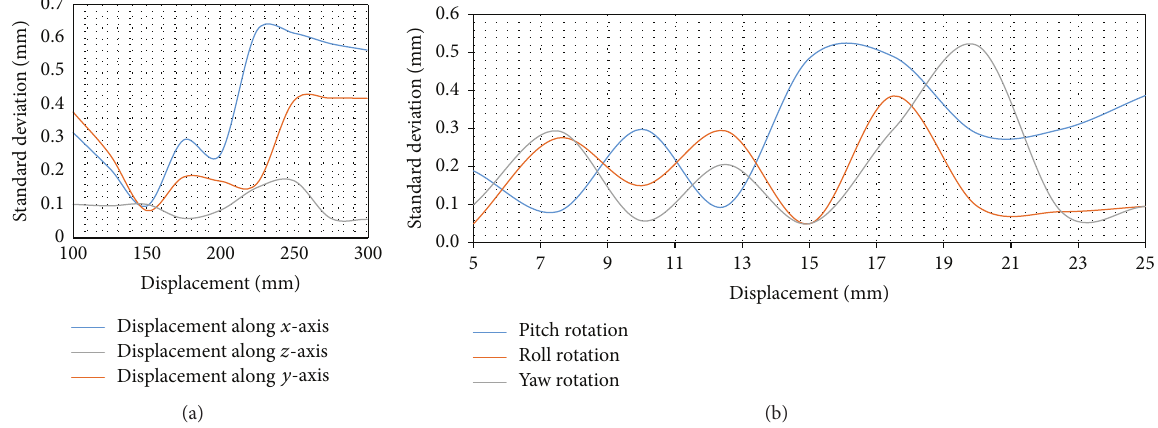
Figure 5: Robot repeatability test; (a) reliability of actuators for displacement along 𝑥 -, 𝑦 - and 𝑧 -axes and (b) reliability of actuators for roll, pitch, and yaw rotations.